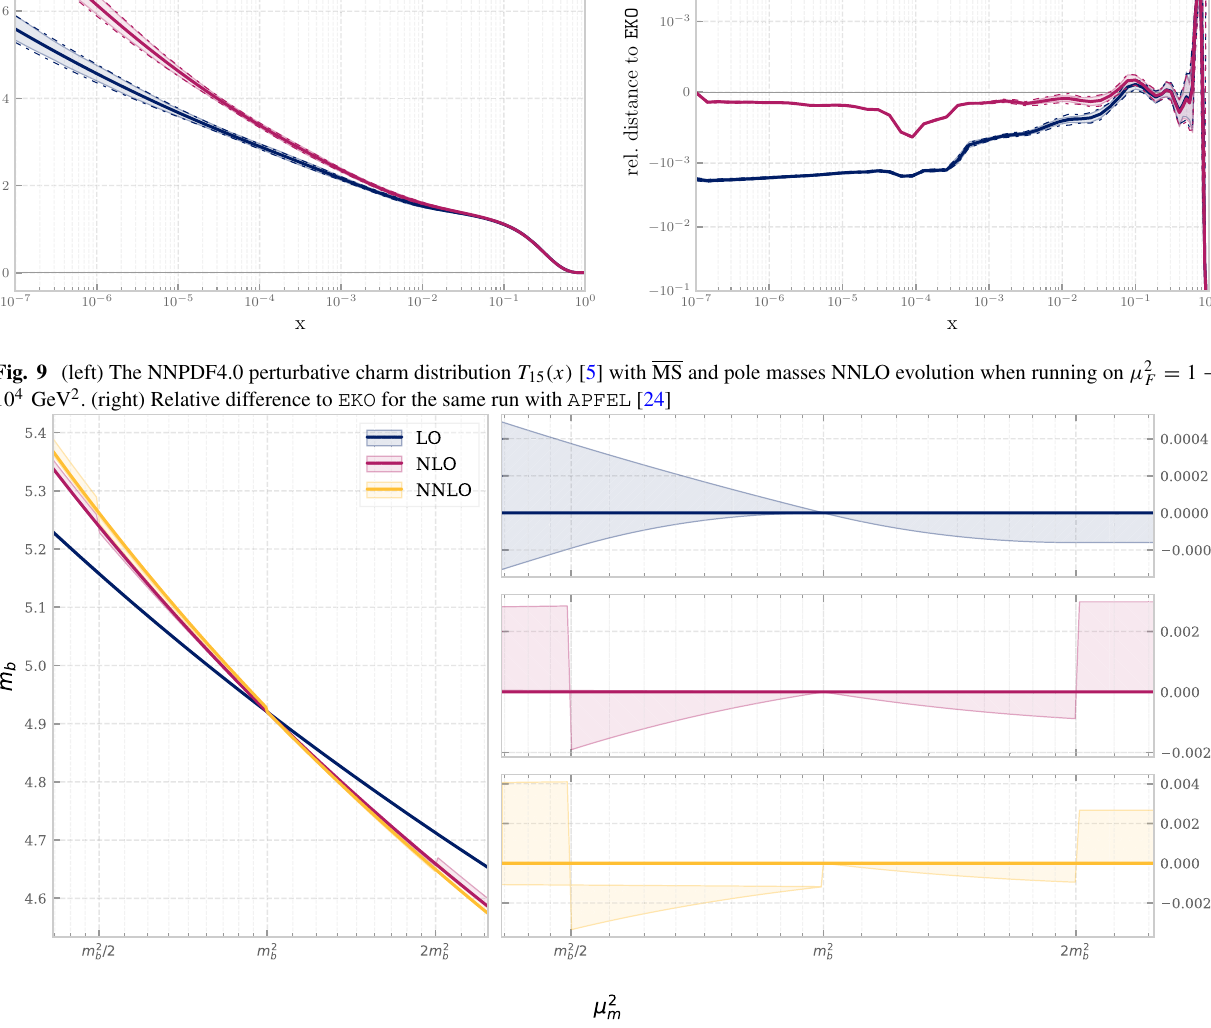
Fig. 10 Running of the bottom quark mass m b (μ 2 m ) for different threshold ratios, similar to Fig. 6. The plot shows how the different choices of matching scales affect the running in the matching region